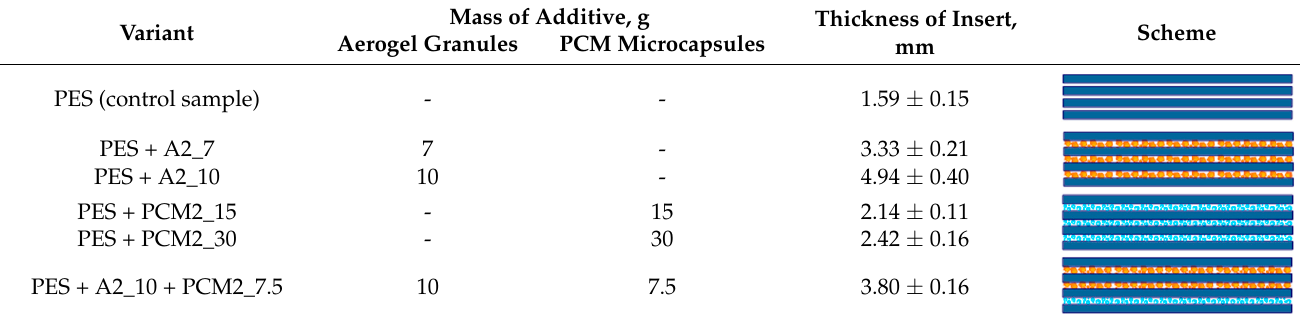
Table 3. Composition of the nonwoven inserts.